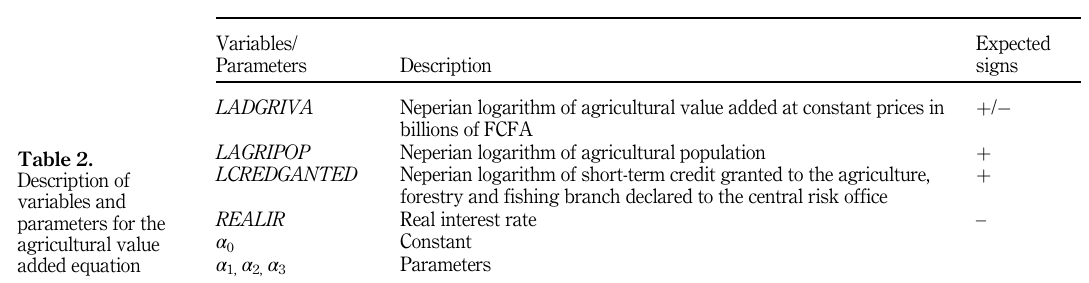
Figure 2. Real interest rate by country (average 1995 – 2016)